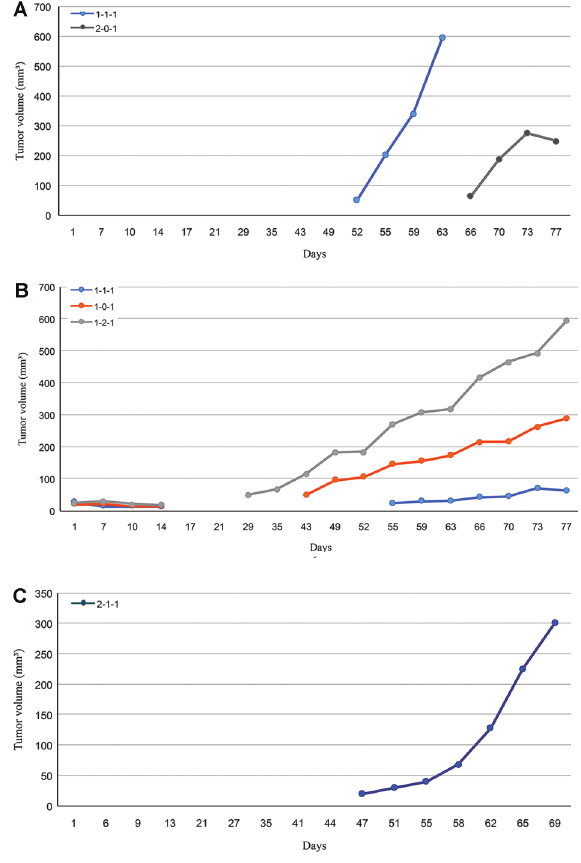
Figure 1. Representative tumor volume (mm 3 ) growth curve of an animal with two P1 patient-derived tumor xenograft (PDTX) tumors established from 010026 lung cancer ( A ), an animal with three P1 PDTX tumors from 010027 liver cancer ( B ), and an animal with one P1 PDTX tumor from 010032 lung cancer ( C